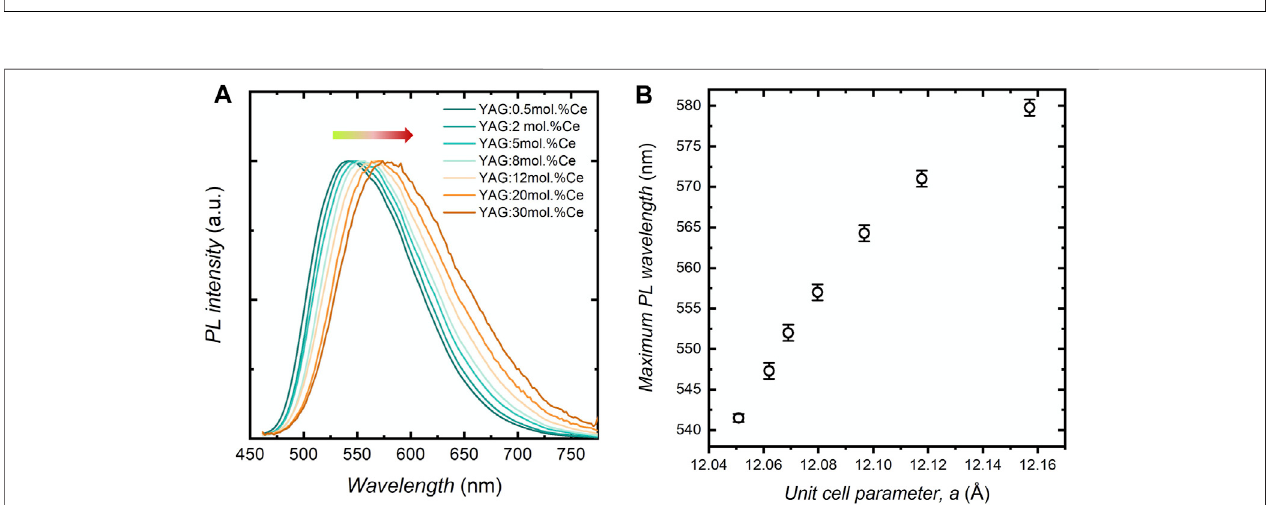
Frontiers in Materials |